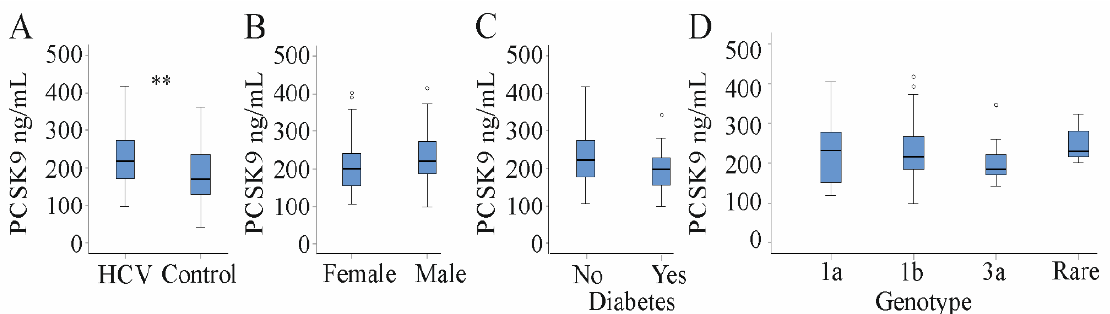
Figure 1. Serum proprotein convertase subtilisin/kexin 9 (PCSK9) in patients with chronic hepatitis C virus (HCV) and controls. ( A ) Serum PCSK9 in patients with chronic HCV and non-infected controls without severe liver diseases; ( B ) serum PCSK9 in female and male HCV patients; ( C ) serum PCSK9 in diabetic and non-diabetic HCV patients; ( D ) serum PCSK9 in patients stratified for HCV genotype (rare group is 6 patients with genotypes other than 1a, 1b, and 3a). Small circles above the boxes mark outliers. ** p < 0.01.